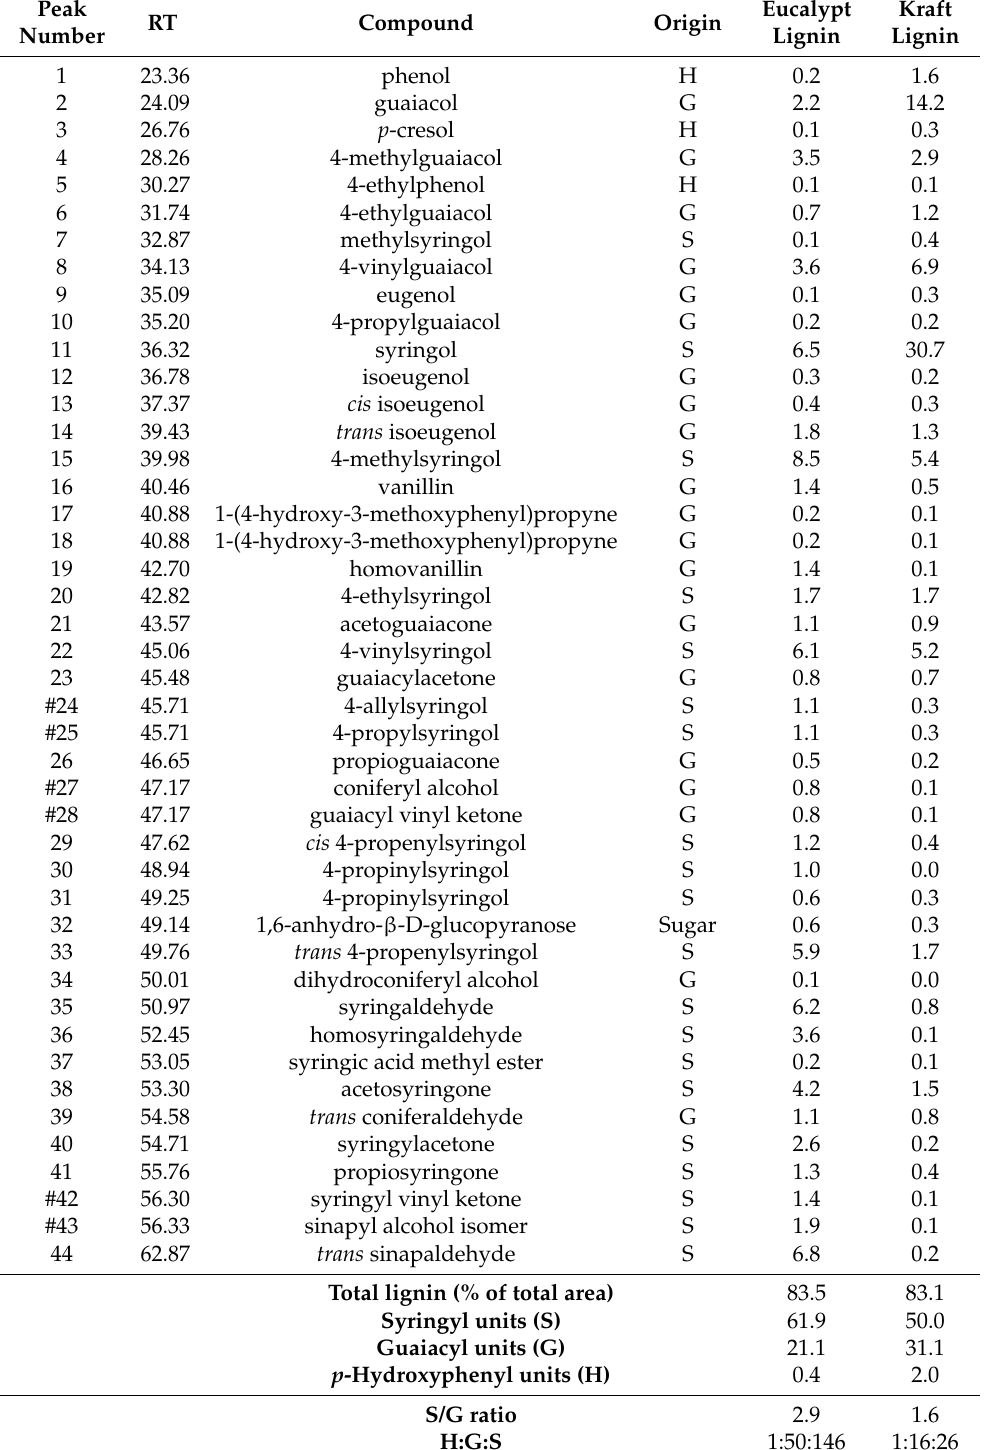
Table 1. Identification and quantification of the compounds obtained by Py-GC/MS of the isolated lignins: Eucalyptus stump lignin and kraft lignin (% of the total area of the